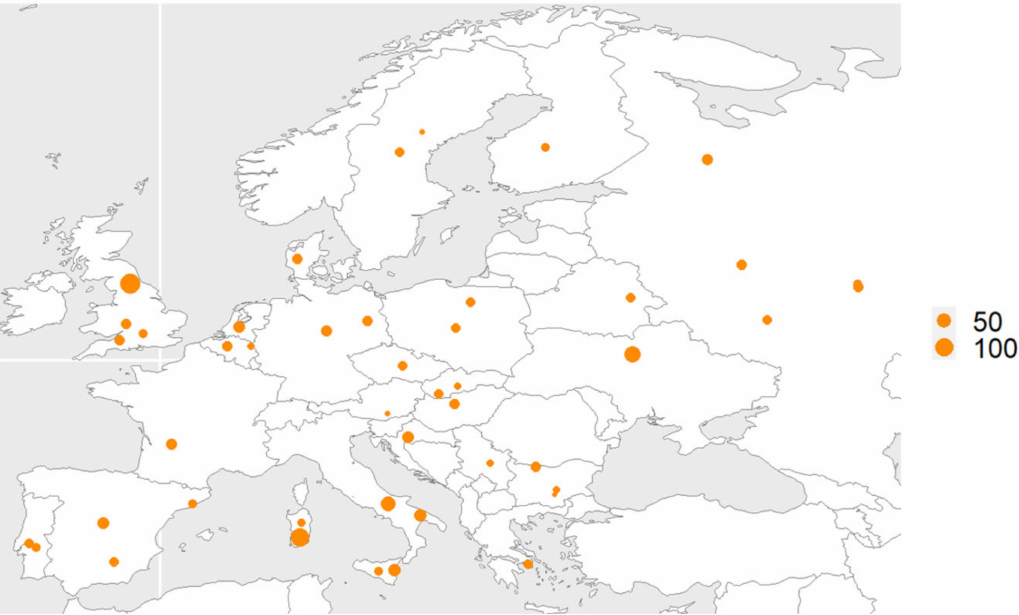
Figure 1. Regional distribution map of 1098 individual European pigs. Refer to the data source article for specific group geographic divisions [22,23]. These dots indicate the distribution, source and quantity of